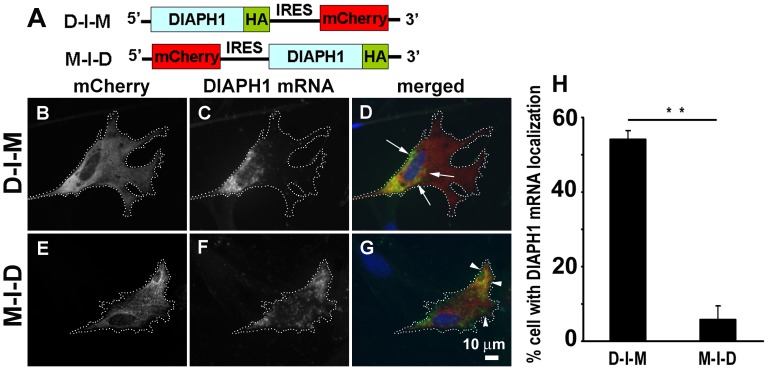
Internal Ribosome entry site mediated translation leads to delocalization of DIAPH1 mRNA.
A.
 Illustration of bicistronic DIAPH1 expression constructs. D-I-M for DIAPH1-IRES-mCherry and M-I-D for mCherry-IRES-DIAPH1. CEF were transfected for 24 hr and processed for DIAPH1 mRNA and HA-tag detection. B–G. Representative transfected cells show localizing DIAPH1 mRNA (green in D, indicated by arrows) and delocalizing DIAPH1 mRNA (green in G, indicated by arrowheads), respectively. Red: mCherry. B–C and E–F are gray scale images for better presentation of the distribution of mCherry protein and DIAPH1 mRNA in cells transfected with the localizing and delocalizing constructs, respectively. H. Quantitative results of DIAPH1 mRNA localization from analysis of 300–500 cells from three independent experiments for each expression construct. Error bars: sem. ** p<0.01.